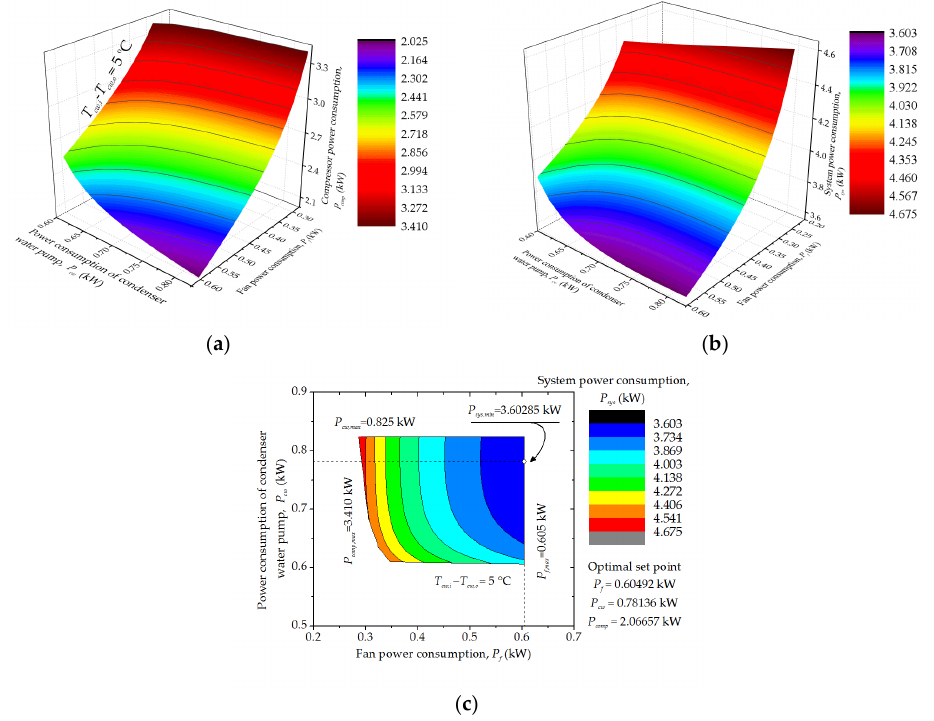
Figure 9. Three optimally controlled variables at a required cooling load of 12.24 kW: ( a ) compressor power consumption versus the power consumptions of fan and condenser water pump; ( b ) system power consumption versus the power consumptions of fan and condenser water pump (Three-dimensional); and ( c ) system power consumption versus the power consumptions of fan and condenser water pump (Two-dimensional).